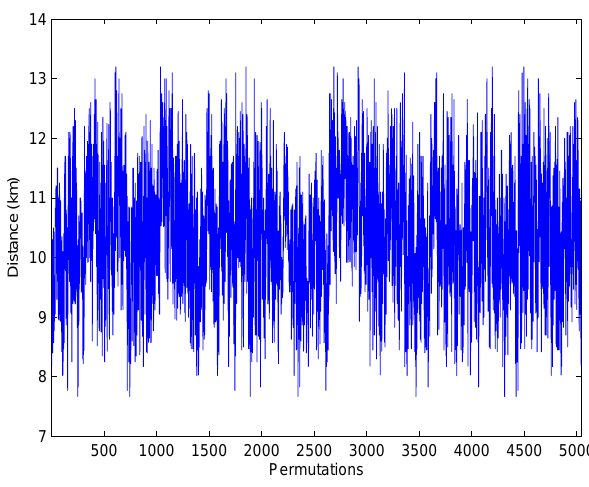
Figure 1. Brute force application, problem n = 7.